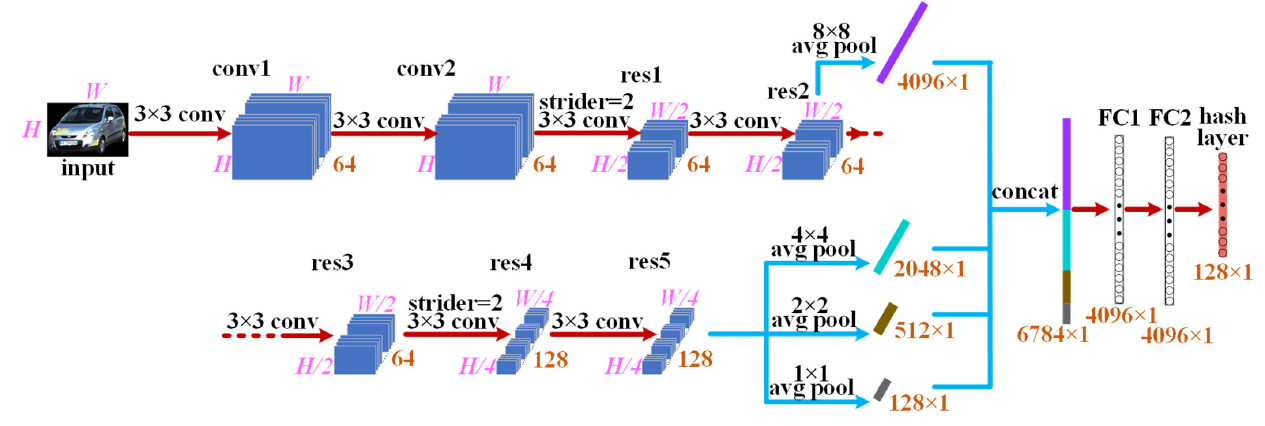
Figure 3. Parameters of the proposed SPPHNet architecture.